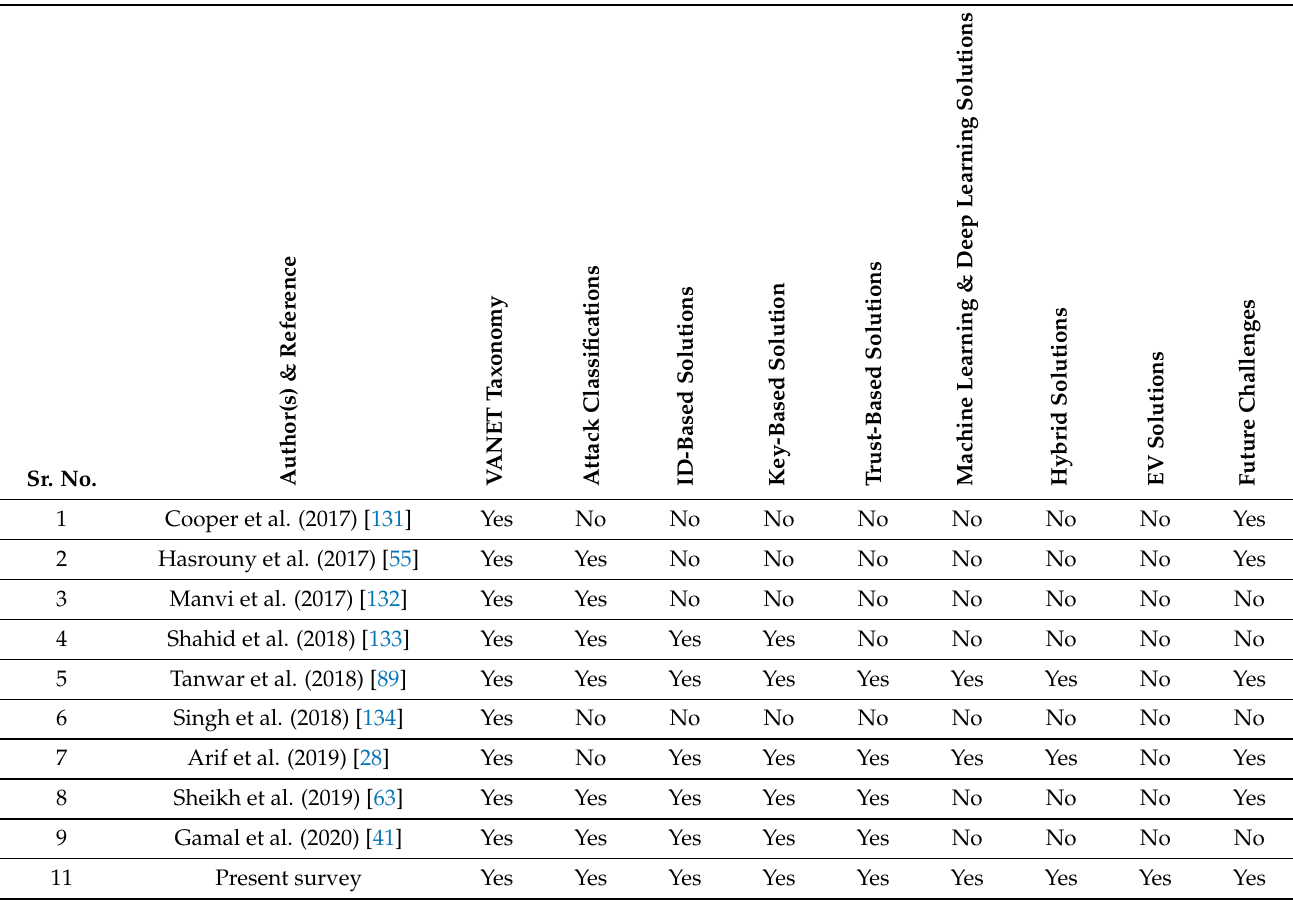
Table 10. Comparison of various related studies in the